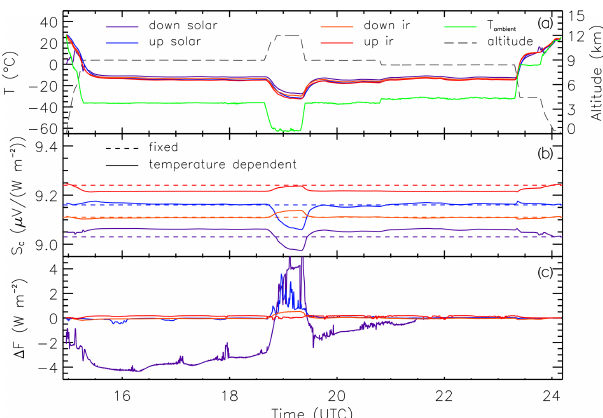
Figure 4. Time series of the ambient air and all radiometer sensor temperatures (a) , the basic and corrected thermopile sensitivities of all radiometers (b) , and the corrected bias of the irradiance due to the temperature dependence of the thermopile sensitivities (c) for the EUREC 4 A flight on 22 January 2020 (flight ID HALO-0122). The flight altitude of HALO is given in panel (a)